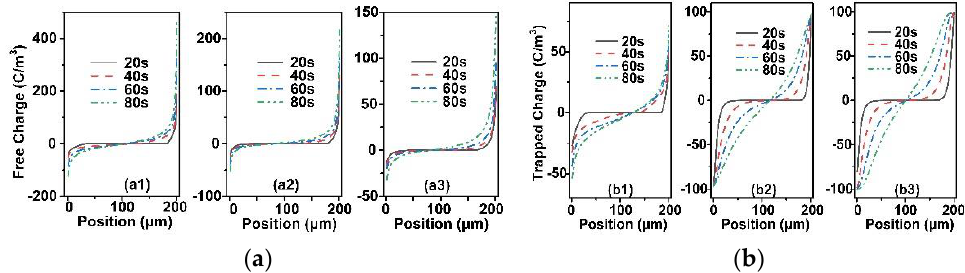
Figure 4. Comparisons of free charge ( a ) and trapped charge ( b ) in the polymer with various orientations: parallel orientation ( a1 , b1 ) random orientation ( a2 , b2 ) perpendicular orientation ( a3 , b3 ).